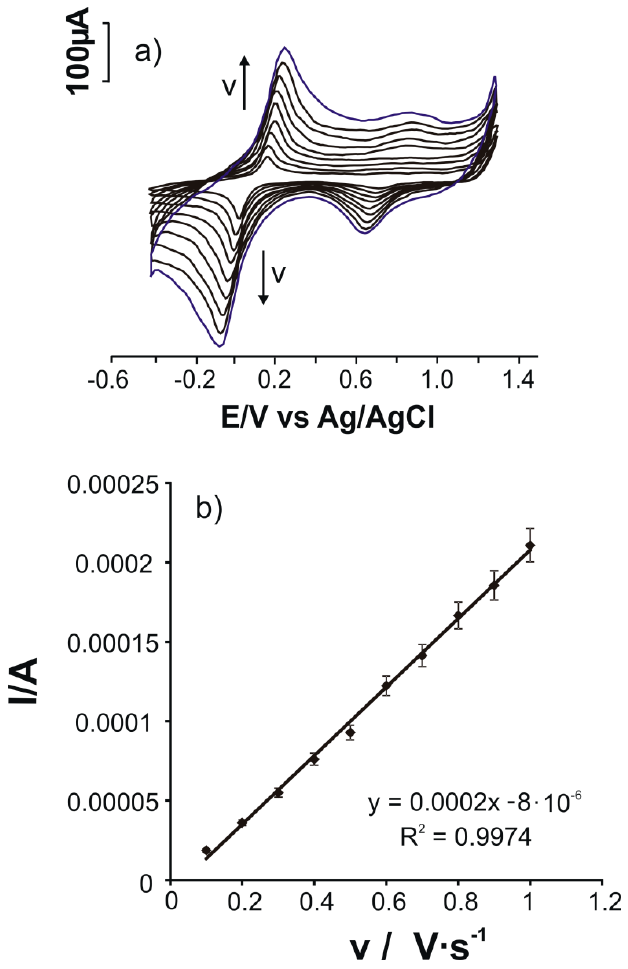
Figure 4. ( a ) Cyclic voltammograms of the PB-SPCE immersed in 10 − 3 M Phe–10 − 1 M KCl solution registered with scan rates between 0.1 and 1.0 V × s − 1 . ( b ) Plot of the linear dependence between the anodic peak current and the scan rates.